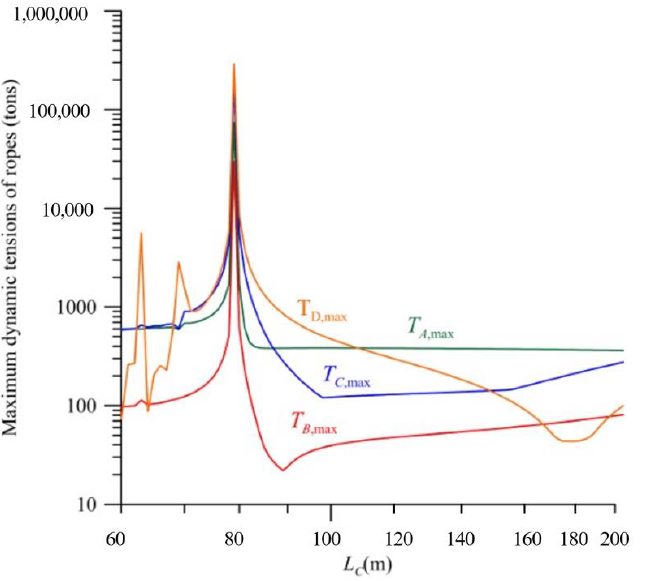
Figure 6. Dynamic tension of the four ropes under the typhoon irregular wave as a function of the diving length L C and the horizontal distance between the turbine and floating platform L E .